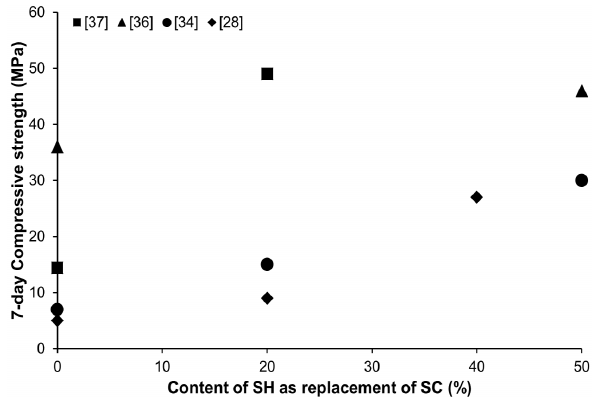
Figure 7: Effect of SH content on the 7-day compressive strength